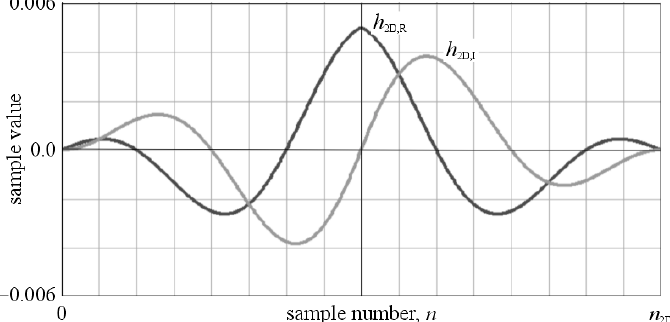
Figure 3. The pulse response of the 2D-FIR filter used in the laboratory tests of the IA.